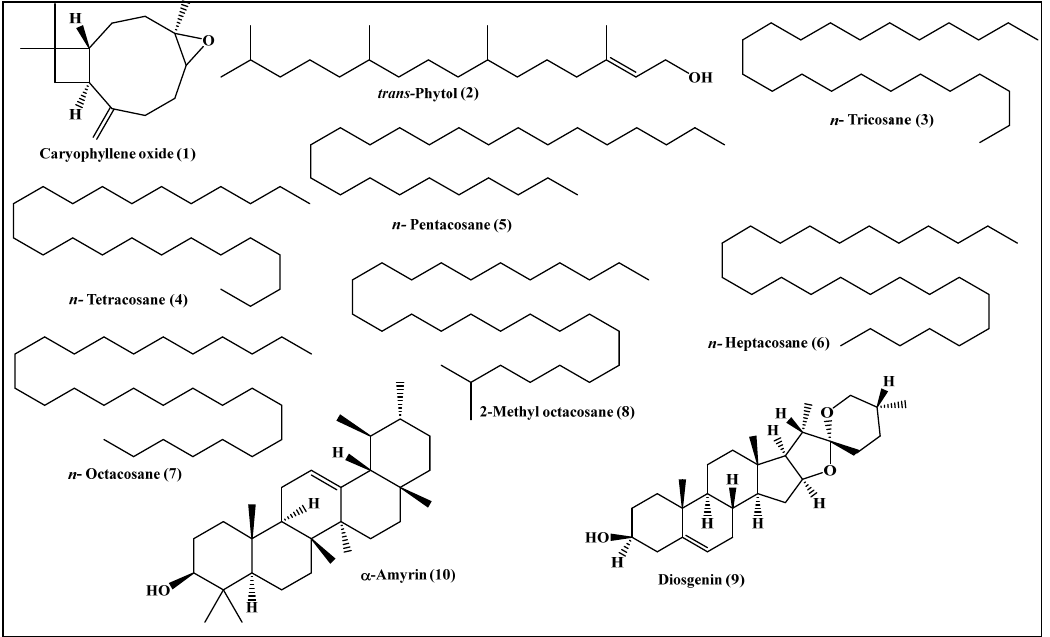
Figure 6. Scheme showing the compounds identified from the n ‐ hexane fraction of P. odorata leaves using GC/MS analysis.